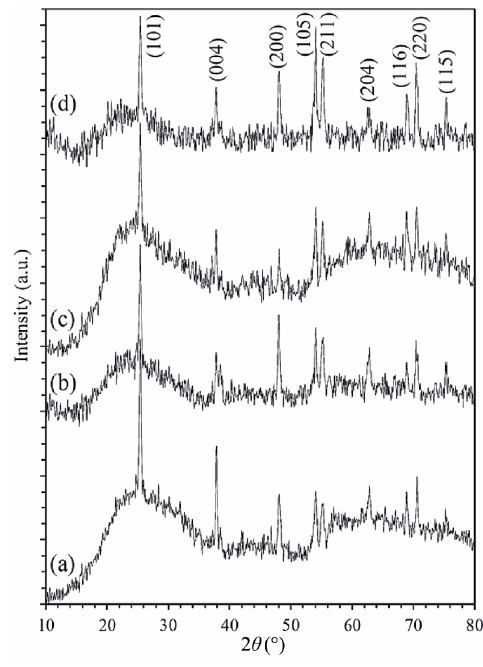
Fig. 3 XRD patterns of (a) TiO 2 -G, (b) TiO 2 -Q, (c) NTiO 2 -G, and (d) NTiO 2 -Q